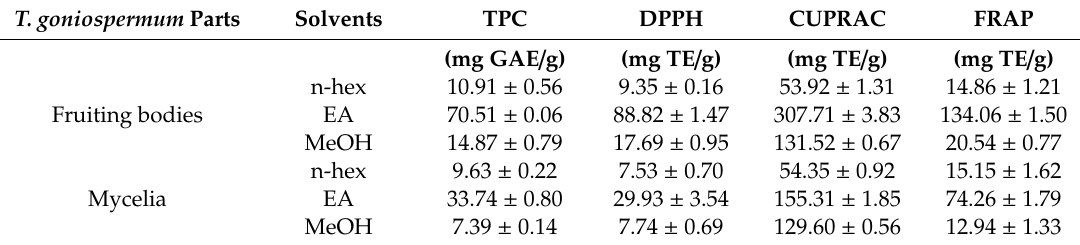
Table 2. Total phenolic and antioxidant properties of the tested extracts.